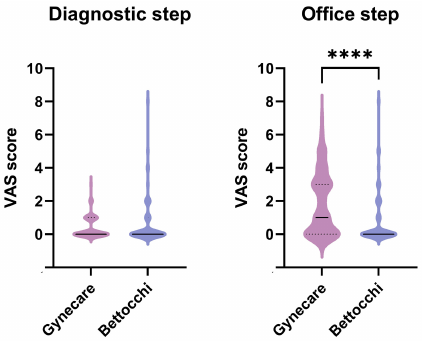
Figure 1. VAS score in the two groups during the diagnostic and the operative steps. **** Mann– Whitney test: p < 0.0001. Table 2. Correlation of VAS score with patients’ clinical and intra-operative characteristics. VAS in the Diagnostic Step